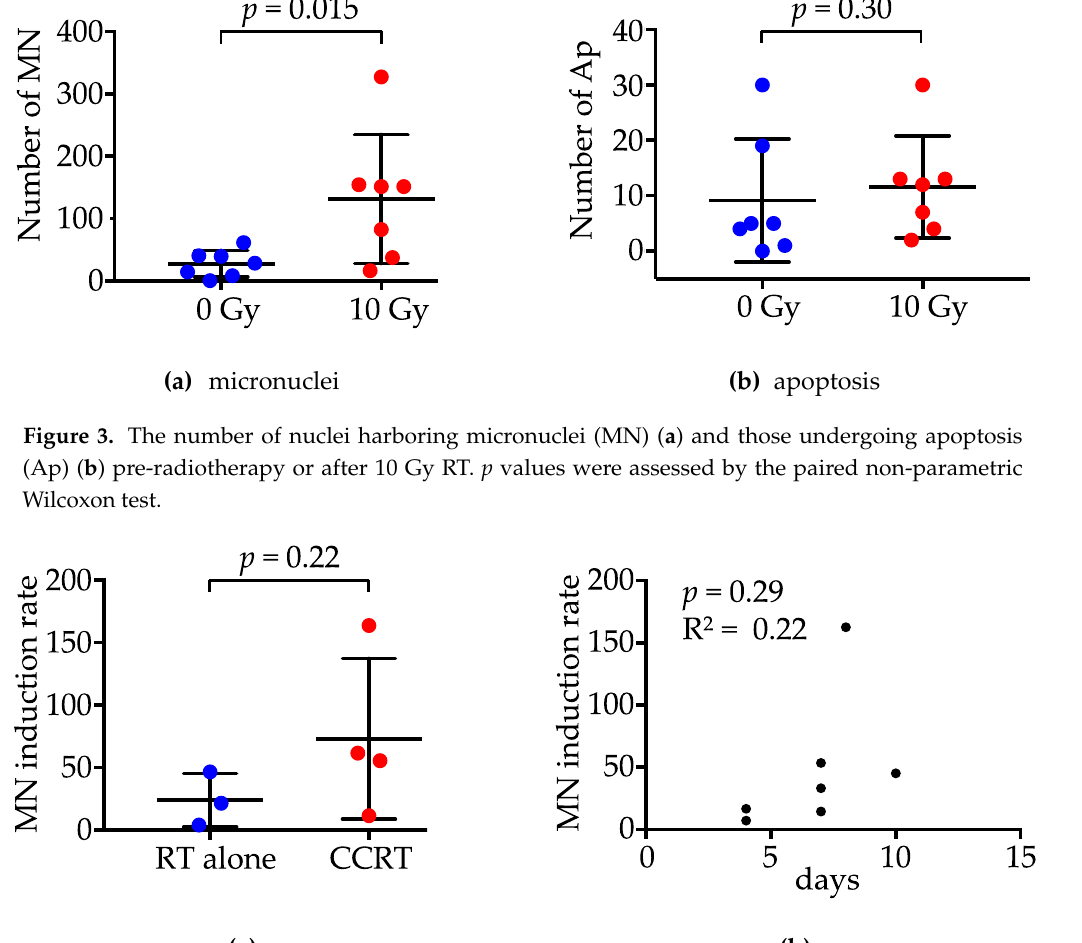
Figure 4. Induction rate of micronuclei (MN) at 10 Gy, relative to pre-RT settings. ( a ) Comparison between patients treated with radiotherapy (RT) alone and those receiving concurrent chemoradiotherapy (CCRT). p value was assessed by the Mann–Whitney test. ( b ) Correlation between the interval between two biopsies and the induction rate of MN. p value and R square value were assessed by Spearman’s Rank Order